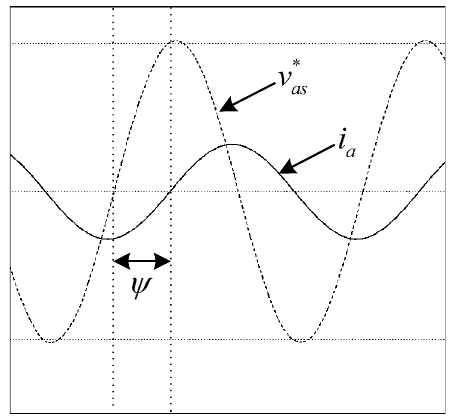
Figure 15. The current phase ψ with a-phase voltage reference * as v and a-phase current